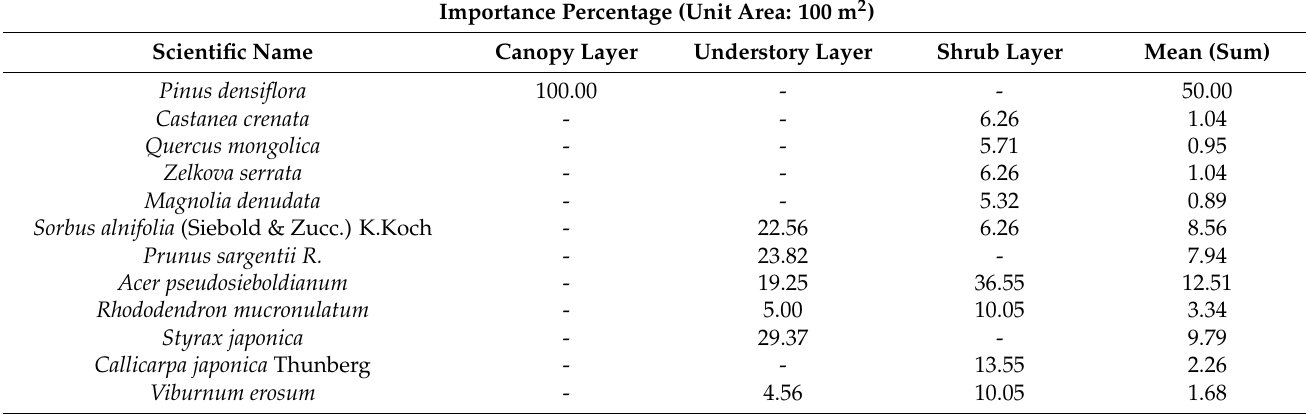
Table 6. Plant community structure of the Quercus mongolica — Pinus densiflora community (survey plot no. 17) in the forest of the Changdeokgung Rear